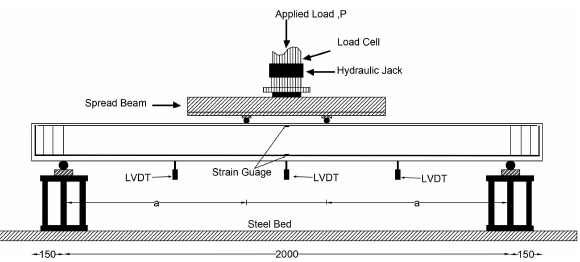
MPa with a corresponding strain equal to 0.055 mm. The